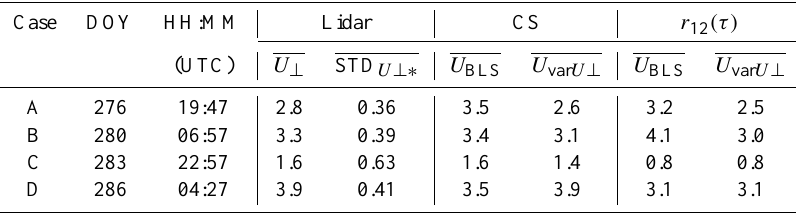
Table 1. Crosswind for the four cases estimated by the Doppler lidar and scintillometer (using either cumulative spectra, CS, or time-lagged correlation function, r 12 (τ) ). U ⊥ var U ⊥ is given by the theoretical CS and r 12 (τ) using the variable U ⊥ (x) estimated by the lidar. Case